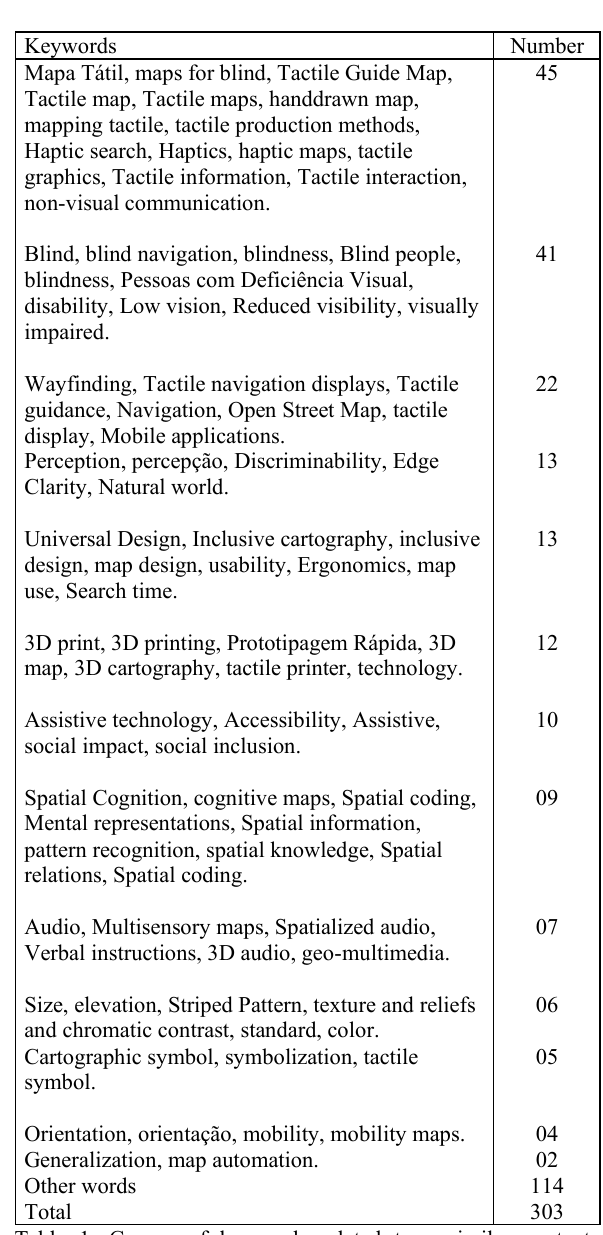
Table 1. Groups of keywords related to a similar context. Organized by the authors.